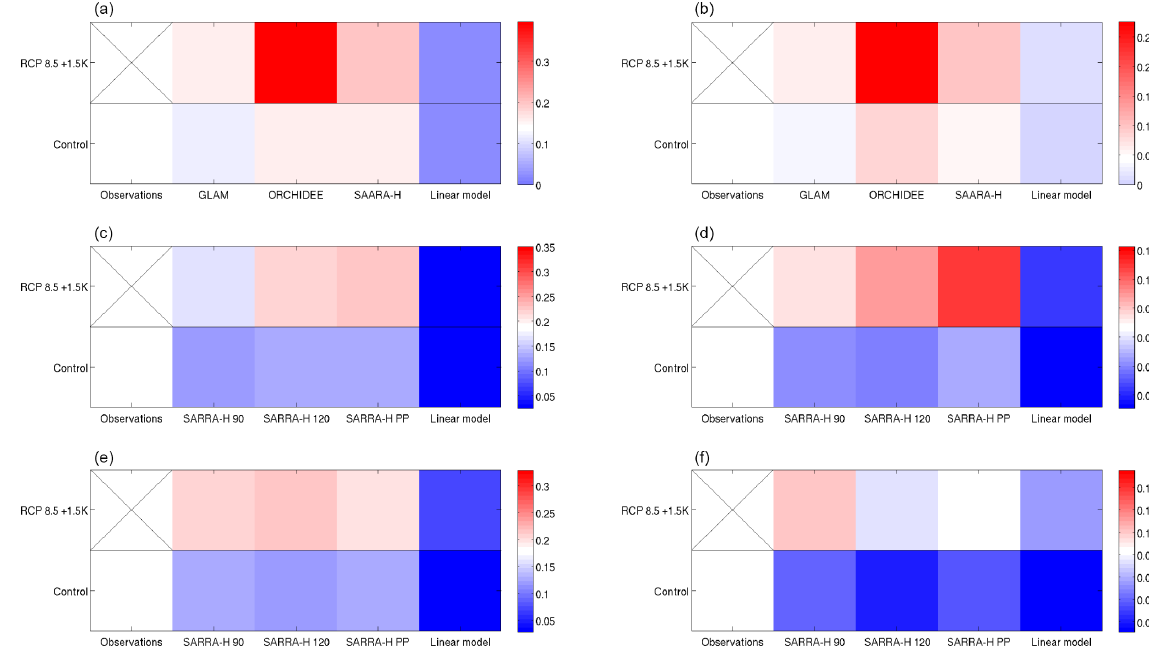
Figure 4. Heat maps of mild (a, c, e) and severe (b, d, f) crop failures for maize (a, b) , millet (c, d) and sorghum (e, f) in West Africa.